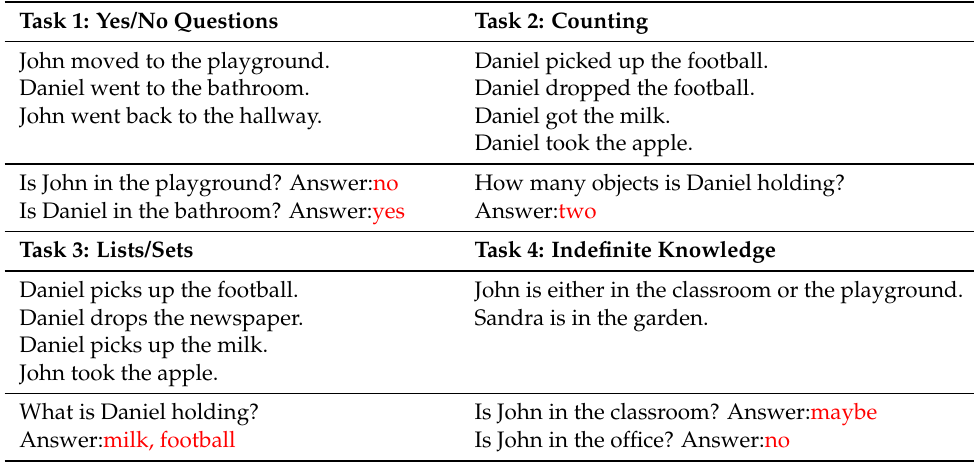
Figure 17. Task examples in the Facebook BAbi dataset [30], the types of these tasks are determined by the content of passages and questions.